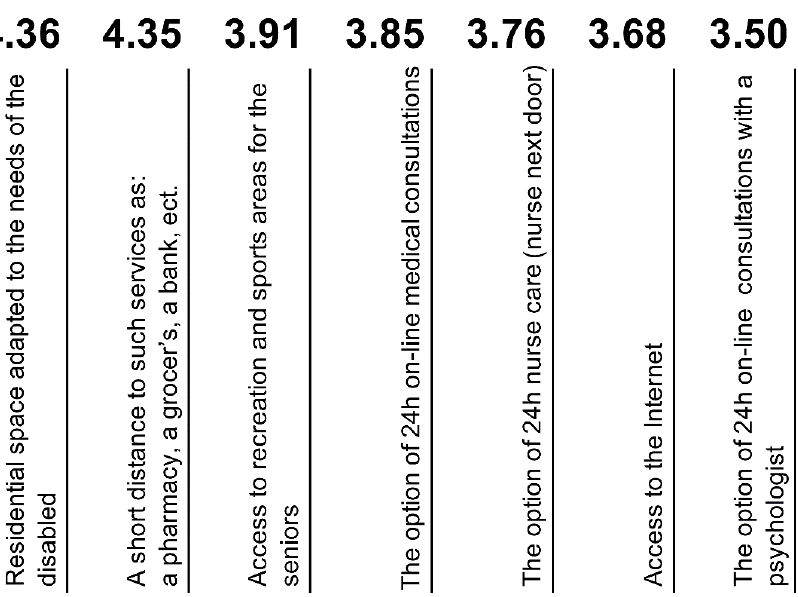
Figure 10. Average rate of a given amenity in the place of residence of the elderly depending on gender.